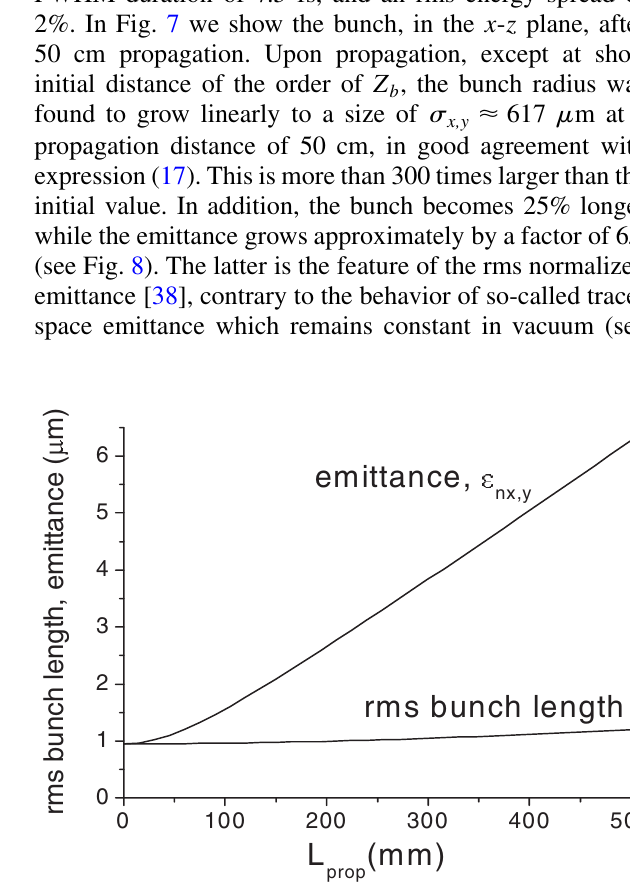
(cid:1) 1 : 91 (cid:1) m , " (cid:1) 0 : 95 (cid:1) m , x;y nx;y